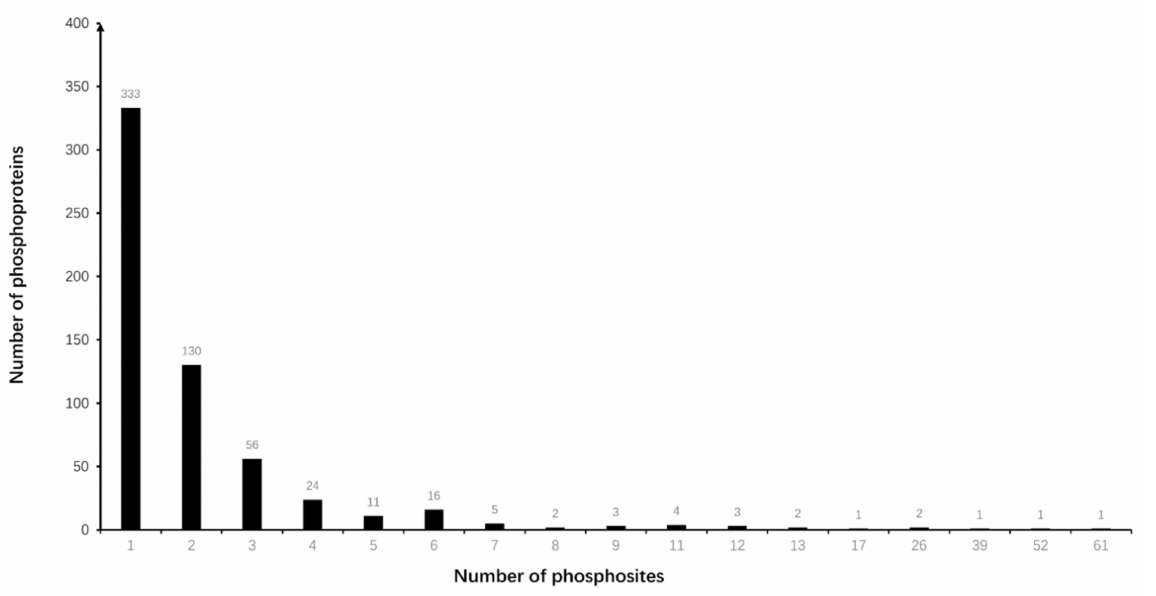
Figure 2. Distribution profile of phosphoproteins based on the number of phosphosites in NF-PitNETs and control pituitary